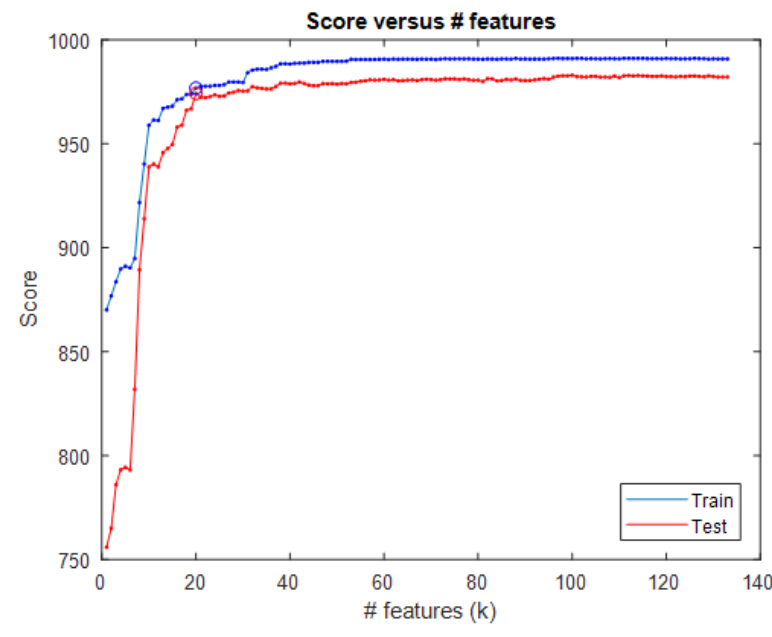
Figure 12. Score value versus number of concatenated